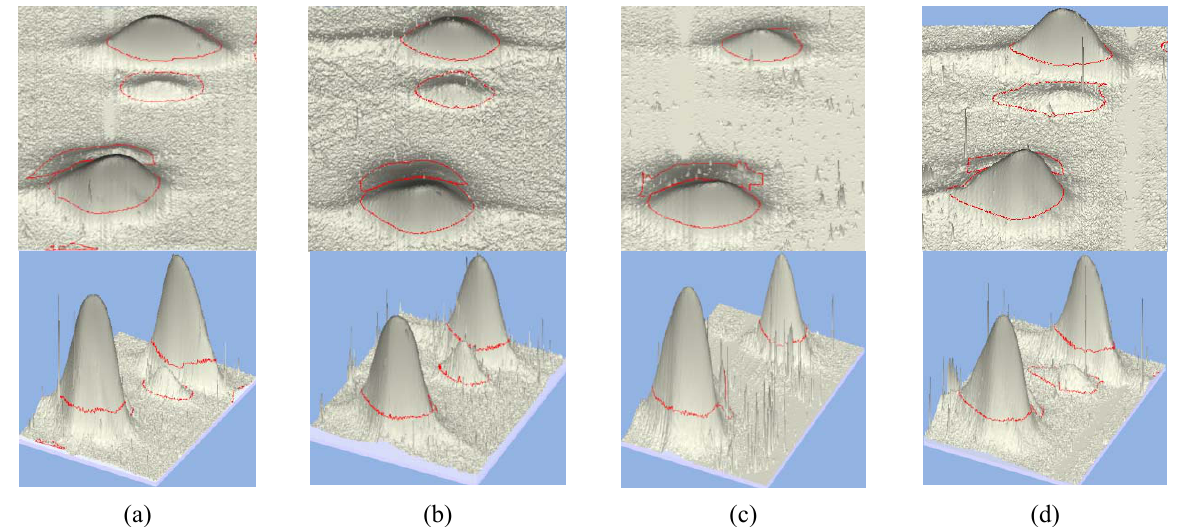
Fig. 5. Zones of certain pork protein markers by computer densitometry techniques (a) α- and β-tropomyosins; (b) myosin light chains 1 MLC; (c) myosin light chains MLC 2; (d) myoglobin.